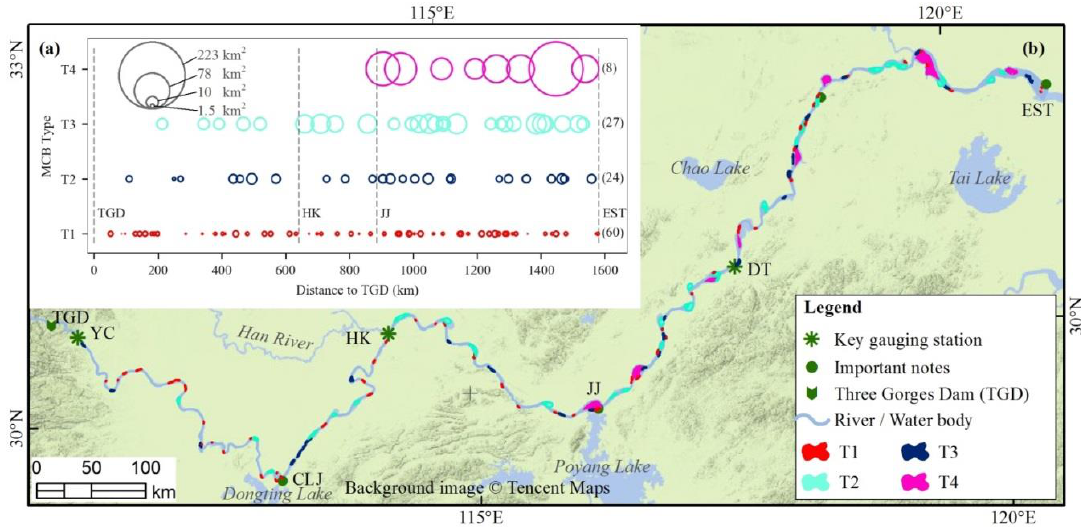
Figure 6. Longitudinal distribution of MCBs along downstream of TGD in 2016.